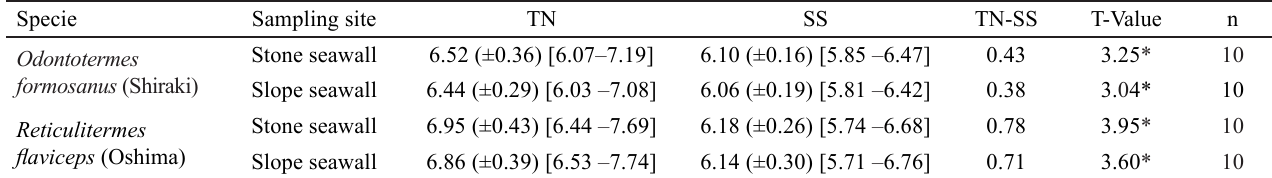
Table 1. pH of termites nest materials and the surrounding soils.